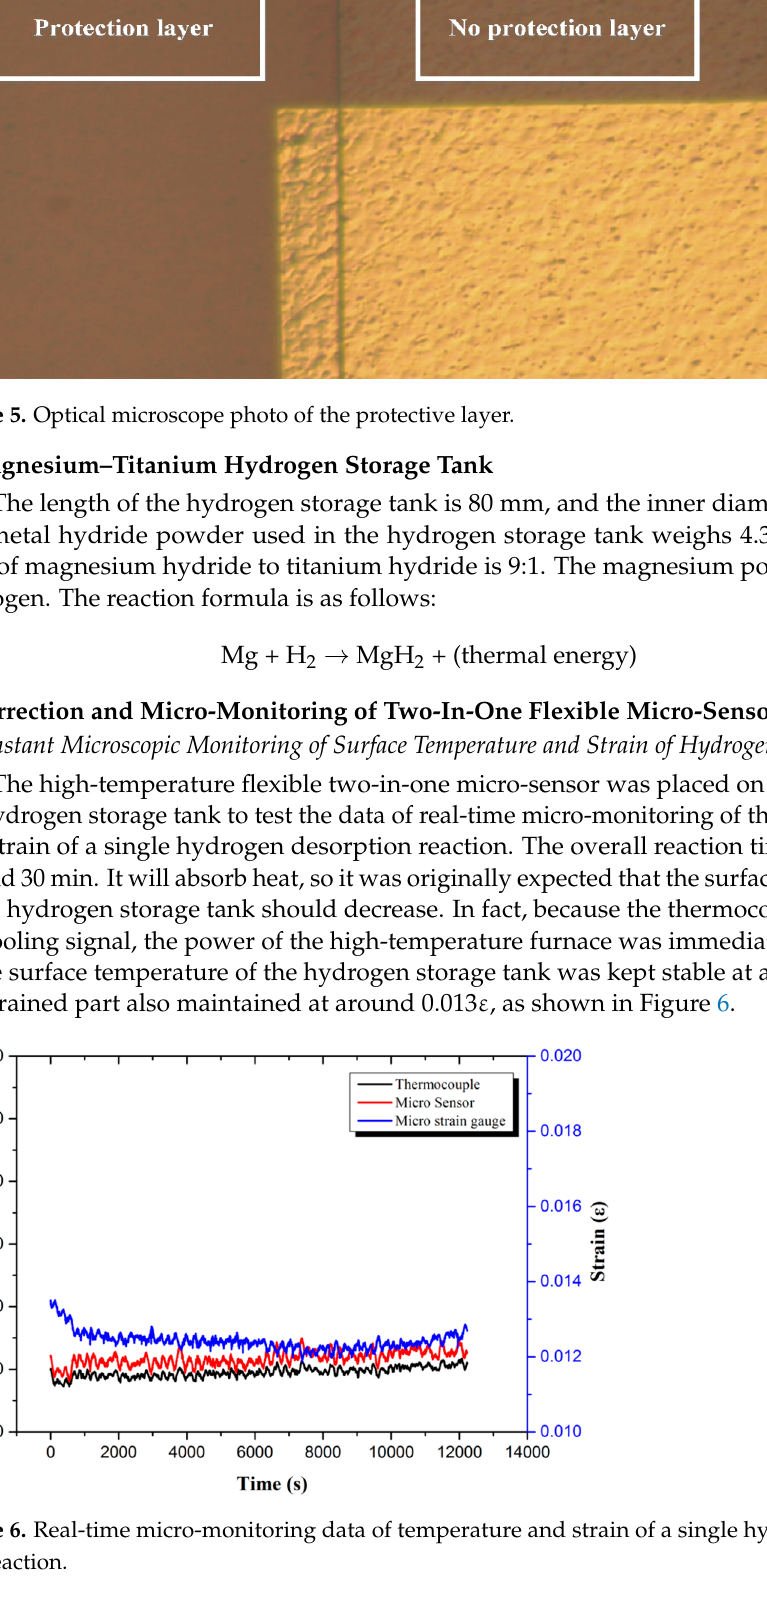
Figure 5. Optical microscope photo of the protective layer.